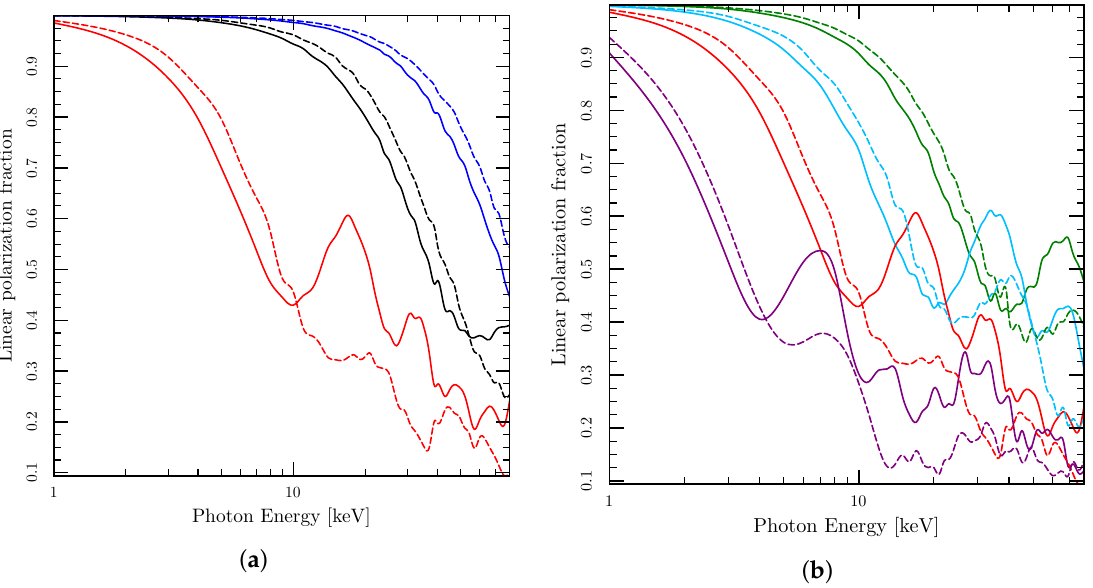
Figure 2. Final polarization fraction vs. photon energy calculated in the 2-fold configuration (solid lines) and in the 1.5-fold configuration (dashed lines): ( a ) left to right, maximum retrograde (90% l − ) angular momentum photons (red), zero angular momentum photons (black) and maximum prograde (90% l + ) angular momentum photons (blue), coming from the ISCO of a black hole with a (cid:63) = 0.9; and ( b ) 90% l − photons for, left to right, a (cid:63) = 0.99 (purple), 0.9 (red), 0.7 (light blue) and 0.5 (green). Figure from [11]. In Figure 2, the dashed lines show the results for the 1.5-fold configuration and the solid lines show